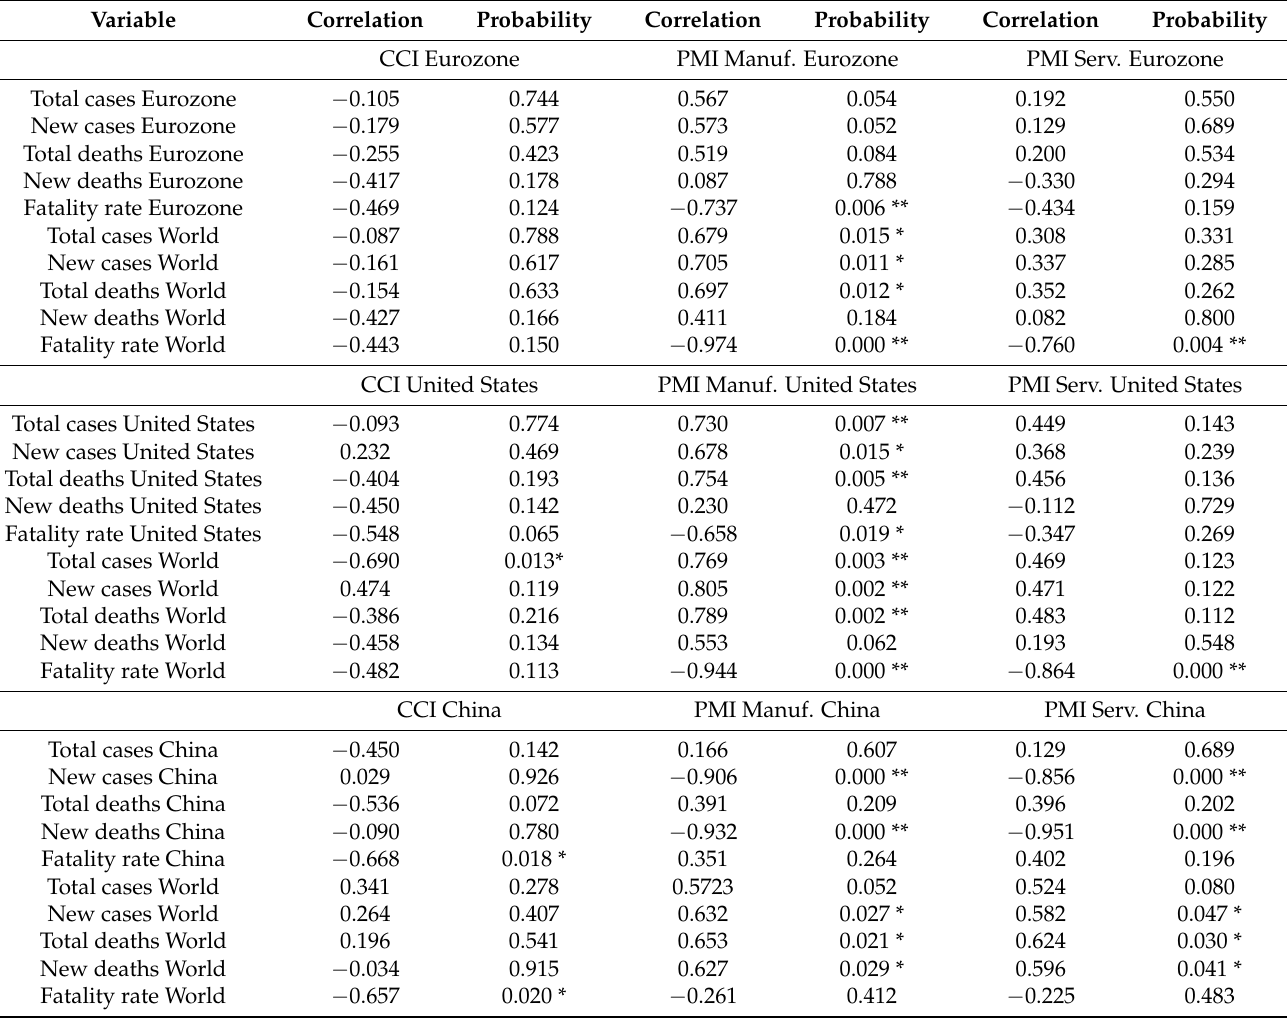
Table 3. Correlation of selected economic sentiment variables and COVID-19-related